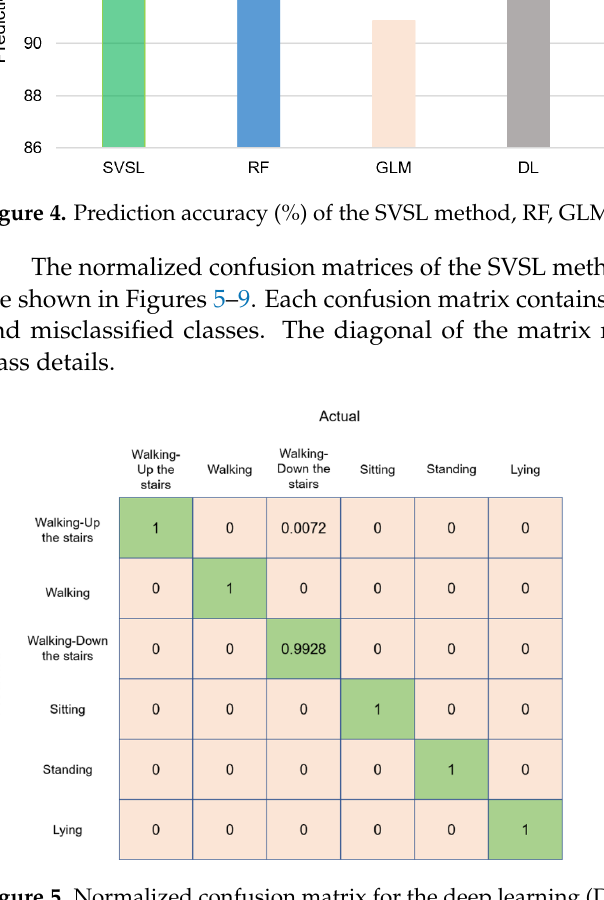
Figure 4. Prediction accuracy (%) of the SVSL method, RF, GLM, DL, and AdaBoost. The normalized confusion matrices of the SVSL method, DL, GLM, RF, and AdaBoost are shown in Figures 5 – 9. Each confusion matrix contains the sum of the rightly classified and misclassified classes. The diagonal of the matrix represents the rightly classified class details.